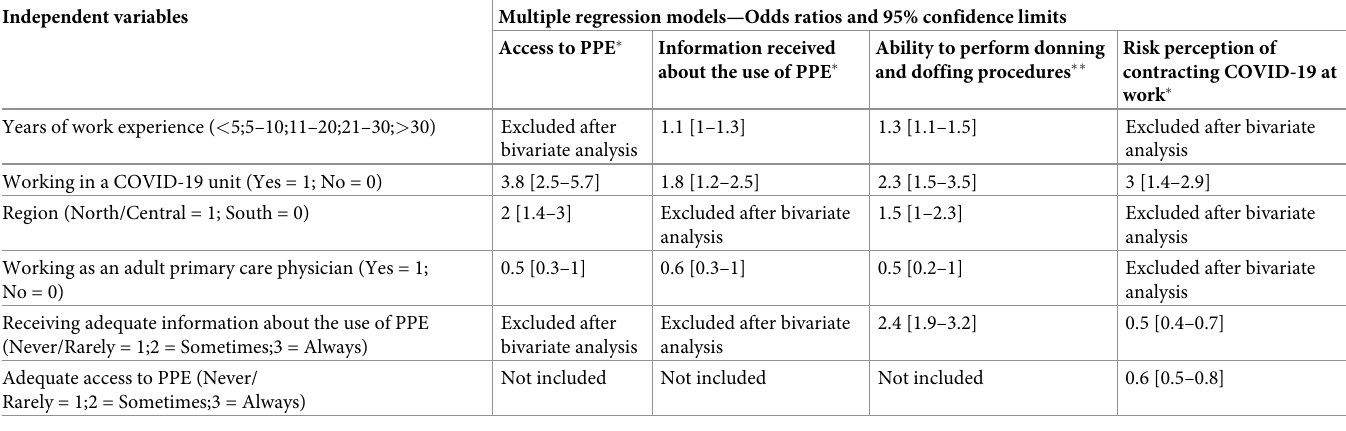
Table 4. Predictors of physicians’ access to PPE, information about the use of PPE, donning and doffing performance, and risk perception at work (n = 516). Independent variables Multiple regression models—Odds ratios and 95% confidence